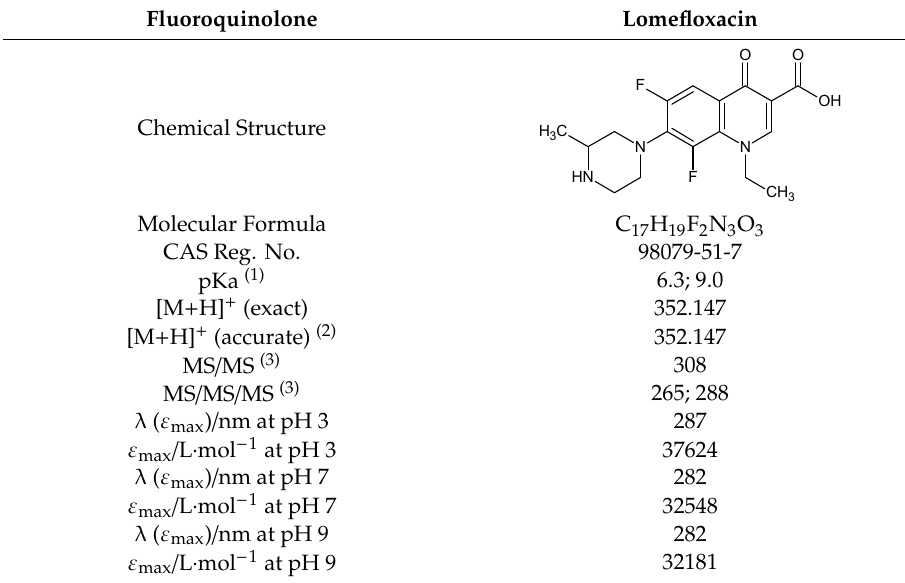
Table 1. Table 1. Properties of Lomefloxacin (LOM) . Table 1. Properties of Lomefloxacin (LOM)